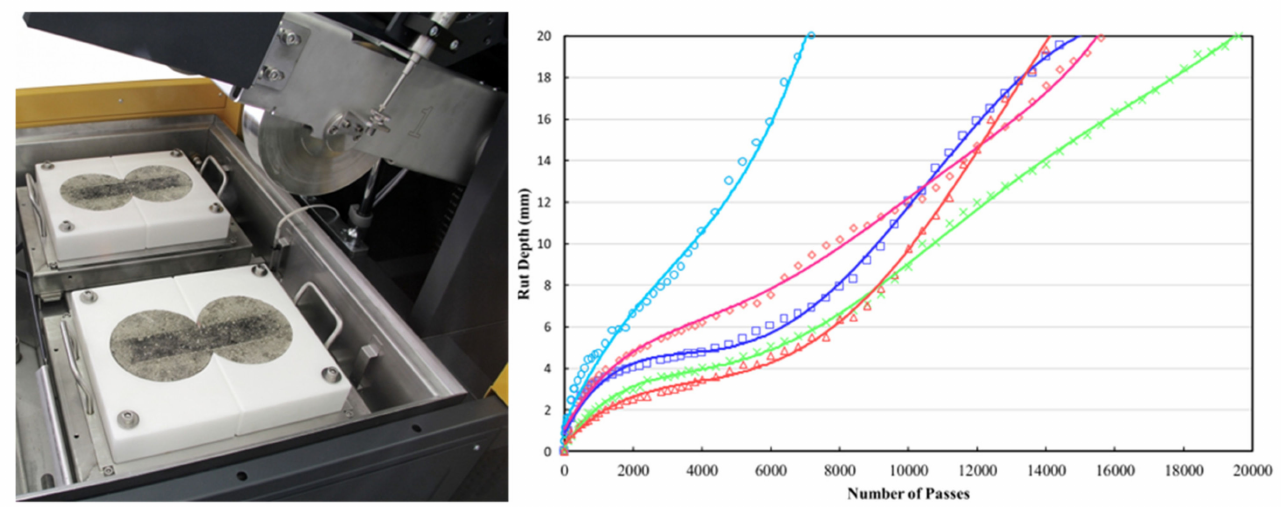
Figure 8. HWTD rutting curves of asphalt mixtures. Reprinted with permission from [79] Copyright Elsevier